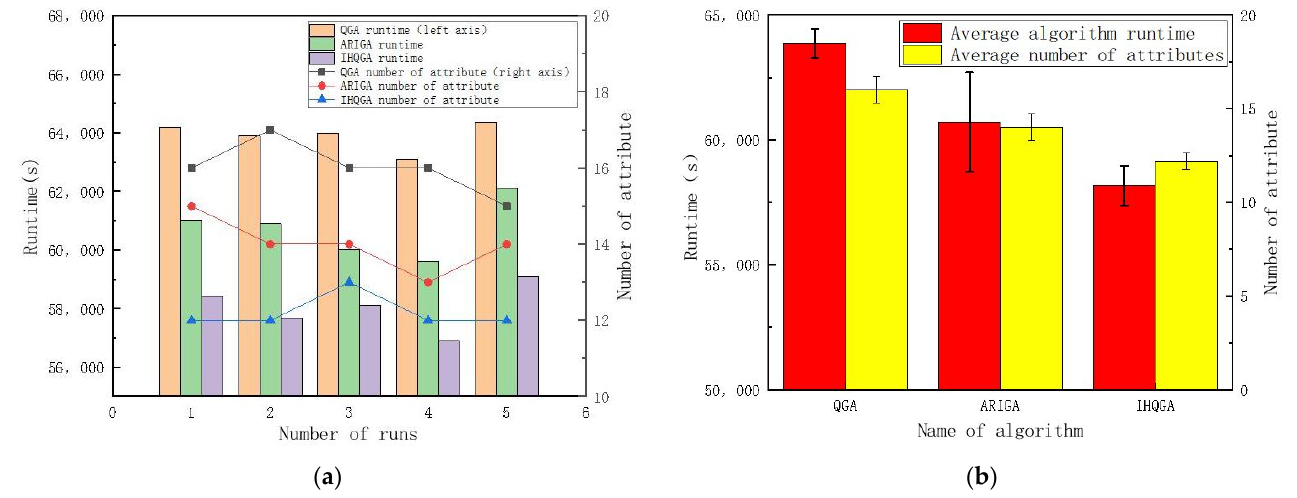
Figure 7. Comparison of attribute reduction time and performance: ( a ) Reduction ability comparison; ( b ) Error analysis.